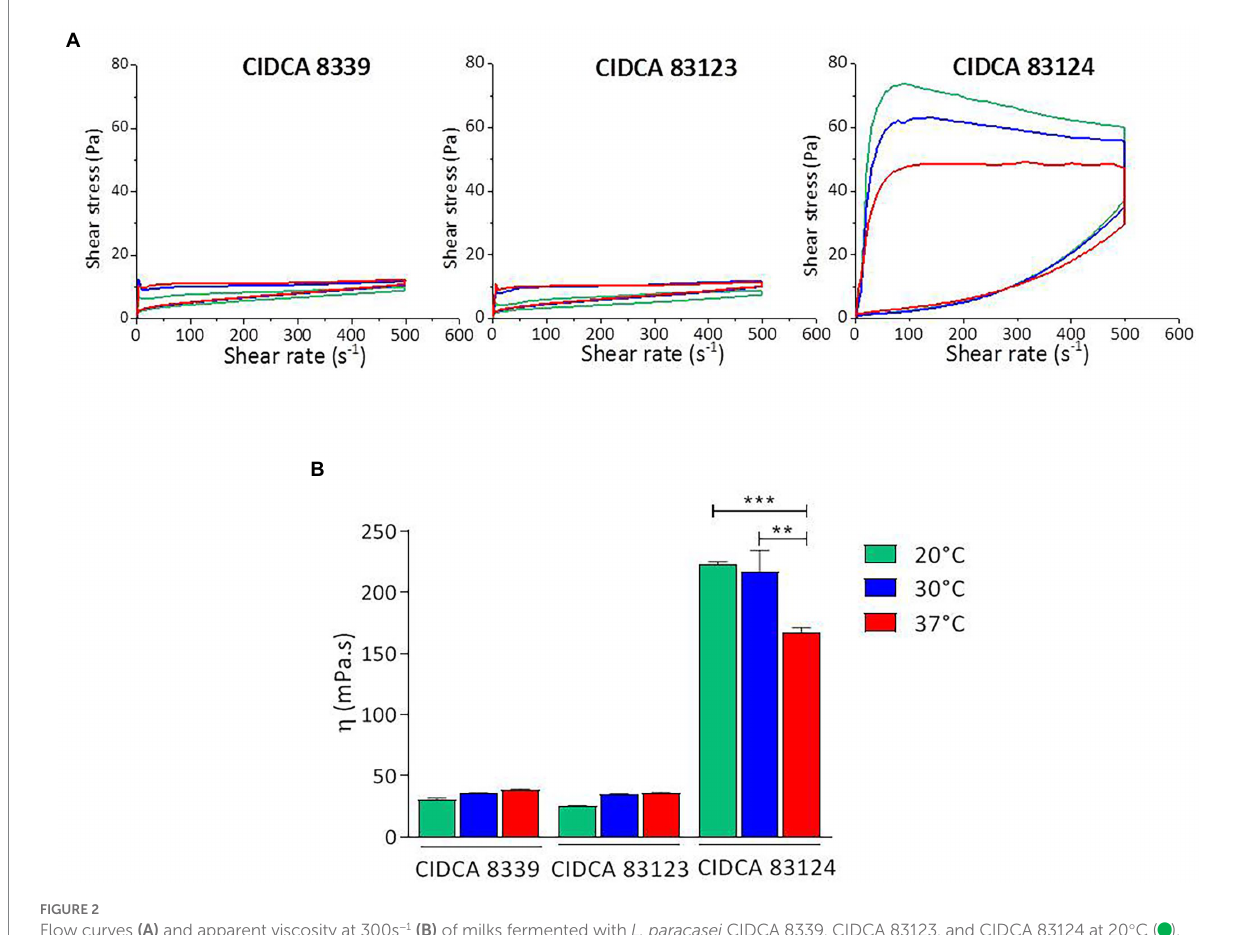
FIGURE 2 Flow curves (A) and apparent viscosity at 300 s − 1 (B) of milks fermented with L. paracasei CIDCA 8339, CIDCA 83123, and CIDCA 83124 at 20 ° C ( ), 30 ° C ( ), and 37 ° C ( ). Significant differences ** p < 0.01, *** p < 0.001.